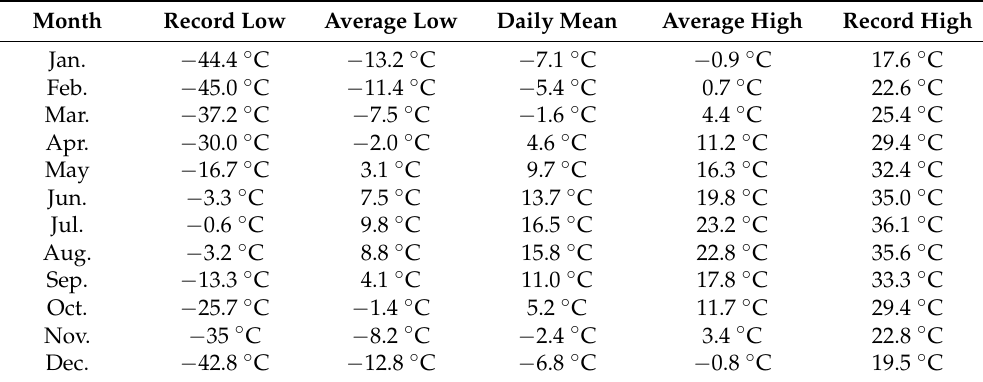
Table 2. Monthly data of outdoor ambient temperatures in Calgary from 1981 to 2010 [52]. Month Record